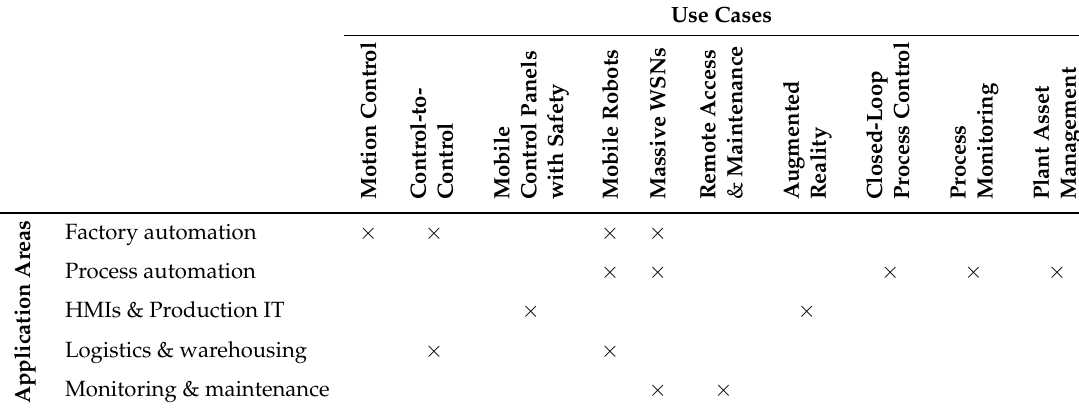
Table 1. Application areas and use cases in a smart factory as defined in 3GPP TR 22.804 [51]. Reprinted with permission from 3GPP™, © 2020.